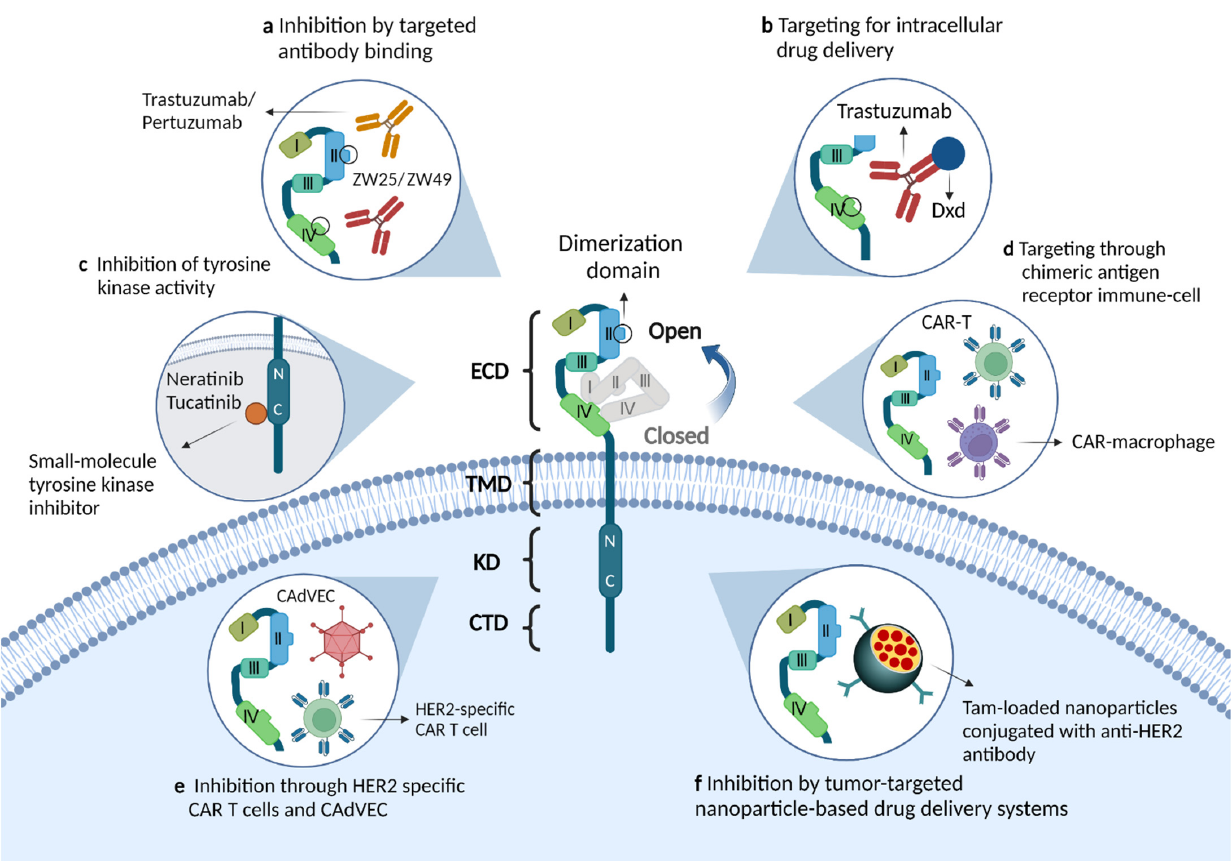
Figure 1. Molecular structure of the ERBB2/HER2 receptor and the mechanism of action of novel therapeutic agents. ( a ) Monoclonal antibodies that target binding to the extracellular structural domain of HER2, including single-epitope monoclonal antibodies (trastuzumab, pertuzumab) and bispecific HER2 antibodies (ZW25, ZW49). The antitumor effects of these drugs are mediated through a variety of mechanisms: inhibition of downstream signaling pathways, involvement in antibody-dependent cellular cytotoxicity or inhibition of receptor dimerization. ( b ) Antibody-drug conjugates targeting HER2, such as trastuzumab emtansine and trastuzumab deruxtecan, release and deliver cytotoxic drugs while binding antibodies and thus exert anti-tumor effects. ( c ) Small molecule inhibitors, such as neratinib and tucatinib, inhibit activation of the PI3K pathway by binding to the tyrosine-kinase domain of the HER2 receptor. ( d , e ) HER2-targeted immunotherapies, such as